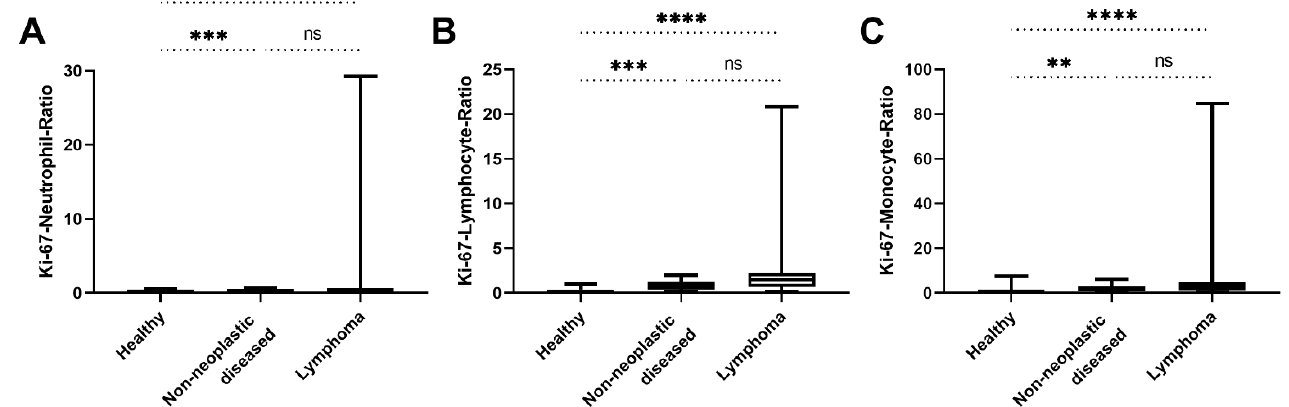
Figure 8. Comparison of ratios between Ki-67 and different inflammatory parameters of healthy dogs, dogs with non-neoplastic diseases, and the dogs with lymphoma. ( A ) The Ki-67–neutrophil ratios of the healthy dogs were significantly lower than those of the non-neoplastic diseased and the lymphoma group ( p = 0.001 and p < 0.0001, respectively). The Ki-67–neutrophil ratios between the non-neoplastic diseased and the malignant tumour group did not differ significantly ( p = 0.076). ( B ) The Ki-67 – lymphocyte ratios of the healthy dogs were also significantly lower than those of the non- neoplastic diseased and the lymphoma group ( p = 0.0002 and p < 0.0001, respectively). Additionally, the Ki-67 – lymphocyte ratios between the non-neoplastic diseased and the lymphoma group did not differ significantly ( p = 0.104). ( C ) The Ki-67-monocyte ratios of the non-neoplastic diseased dogs were significantly higher than those of the healthy group and the healthy group had significantly lower values than the lymphoma group ( p = 0.005 and p < 0.0001, respectively). The Ki-67 – monocyte ratios between the non-neoplastic diseased and the lymphoma group did not differ significantly ( p = 0.16). (ns) not significant; (**) p < 0.01; (***) p < 0.001; (****) p < 0.0001.